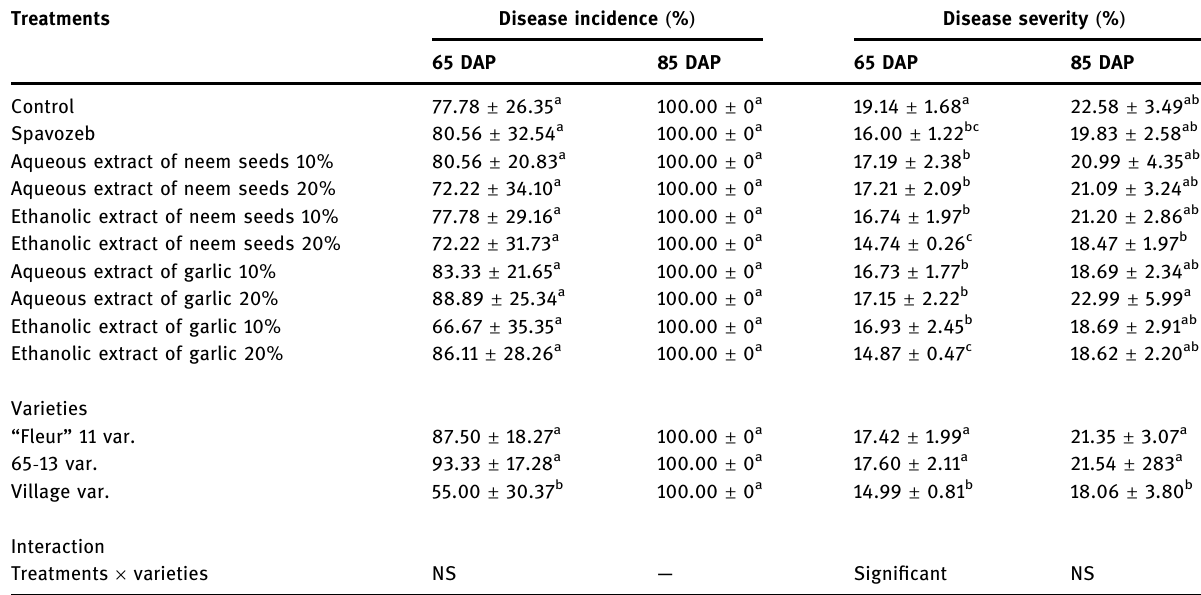
Table 6: Incidence and severity of CLS disease Treatments Disease incidence ( % )